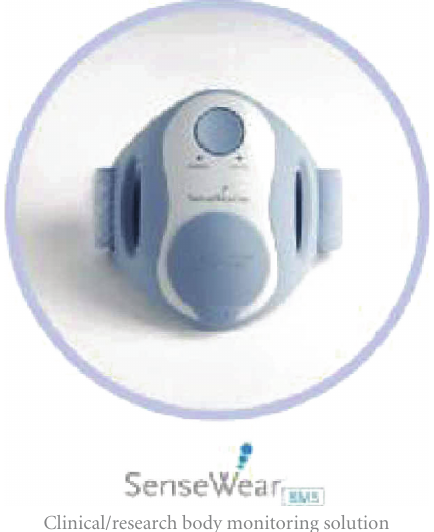
Figure 1: The SenseWear BMS. Source: